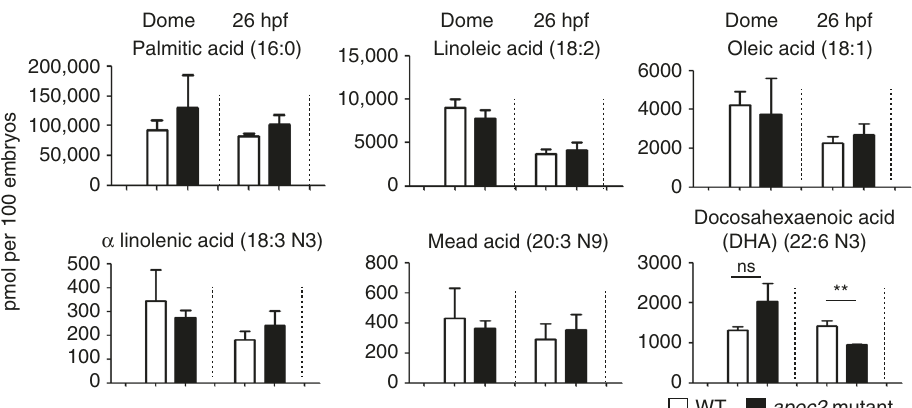
Fig. 6 Reduced DHA levels in apoc2 mutants. FFAs in WT and apoc2 mutants at dome and 26 hpf stages ( n = 3; each replicate is a pool of 20 embryos); mean ± SEM; ** P < 0.01 (Student ’ s t